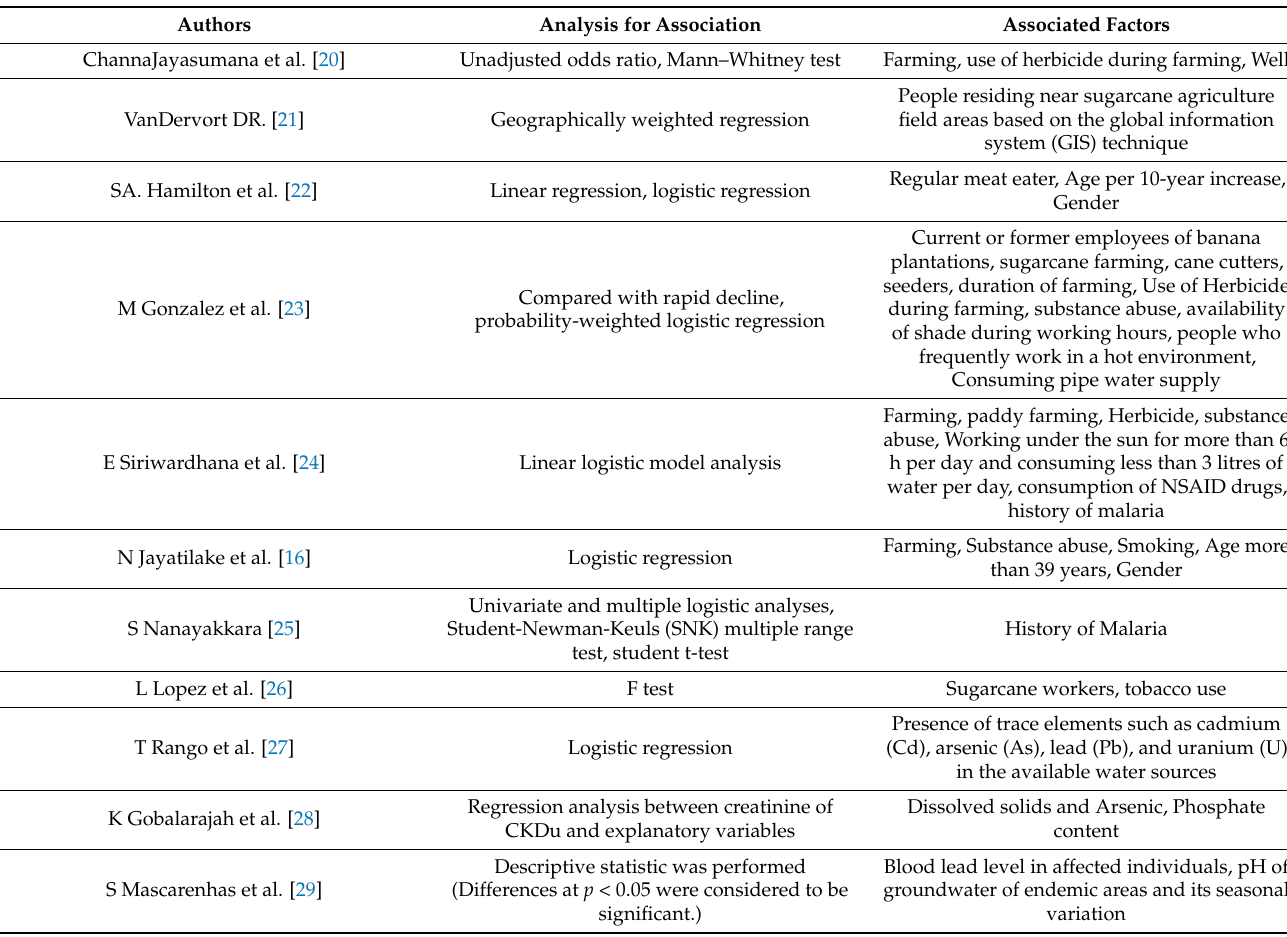
Table 4. Associated factors and types of